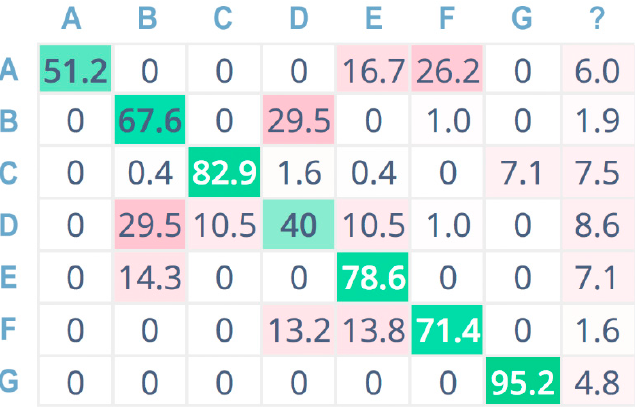
Figure 9. Confusion matrix adopting linear spectrogram pre-processing, 32 bit.